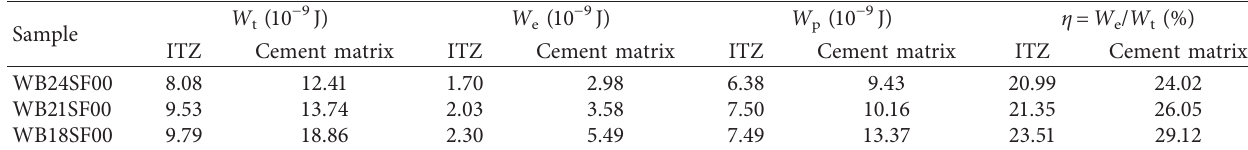
Figure 9: Indentation hardness with distance from the steel-fiber surface at different silica fume contents and water-binder ratios. (a) Water-binder ratio of 0.18. (b) Water-binder ratio of 0.21. (c) Water-binder ratio of 0.24. Table 5: W t and η at different water-binder ratios when silica fume content was 0%.